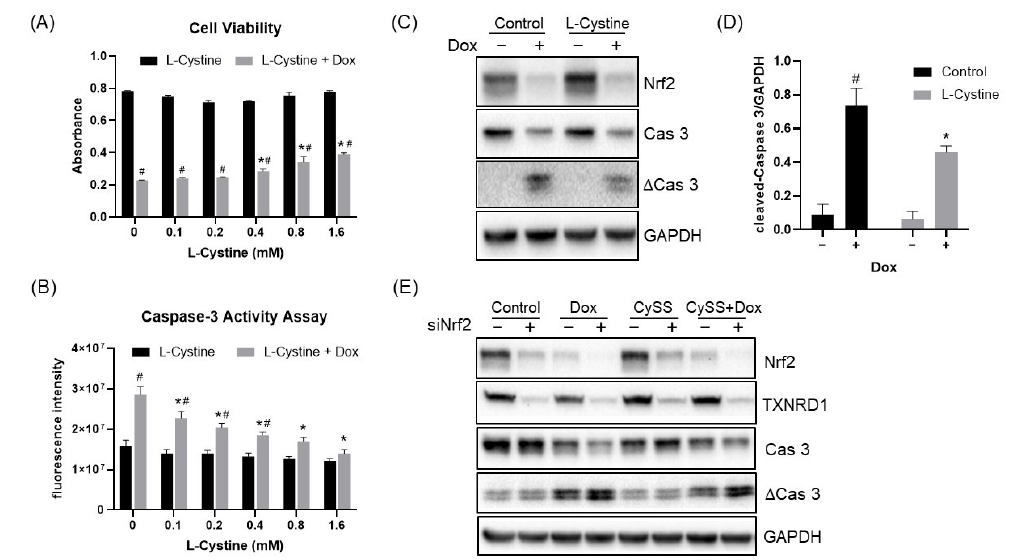
Figure 13. L-Cystine Protects Against Apoptosis. HeLa cells without transfection ( A – D ) or with transfection of control or Nrf2 siRNA for 48 h ( E ) were pre-treated with indicated doses of L-Cystine ( A , B ) or 0.8 mM L-Cystine ( C – E ) for 8 h followed by 2 μ M doxorubicin (Dox) treatment for 24 h. Cells were collected for measurements of cell viability using MTT assay (A), apoptosis using caspase assay with Ac-DEVD-AMC as the substrate ( B ), caspase-3 cleavage by Western blot, using GAPDH as a loading control ( C – E ). Nrf2 protein and its downstream gene TXNRD1-encoded protein were measured to demonstrate the efficacy of siRNA ( D , E ). The data are presented as means ± SD from triplicates. * or # indicates statistically significant compared to Dox treatment alone, or the same dose of L-Cystine without Dox treatment, respectively, as the adjusted p value < 0.05 by two-way ANOVA, corrected by Turkey‘s multiple comparisons test ( A , B , D ).